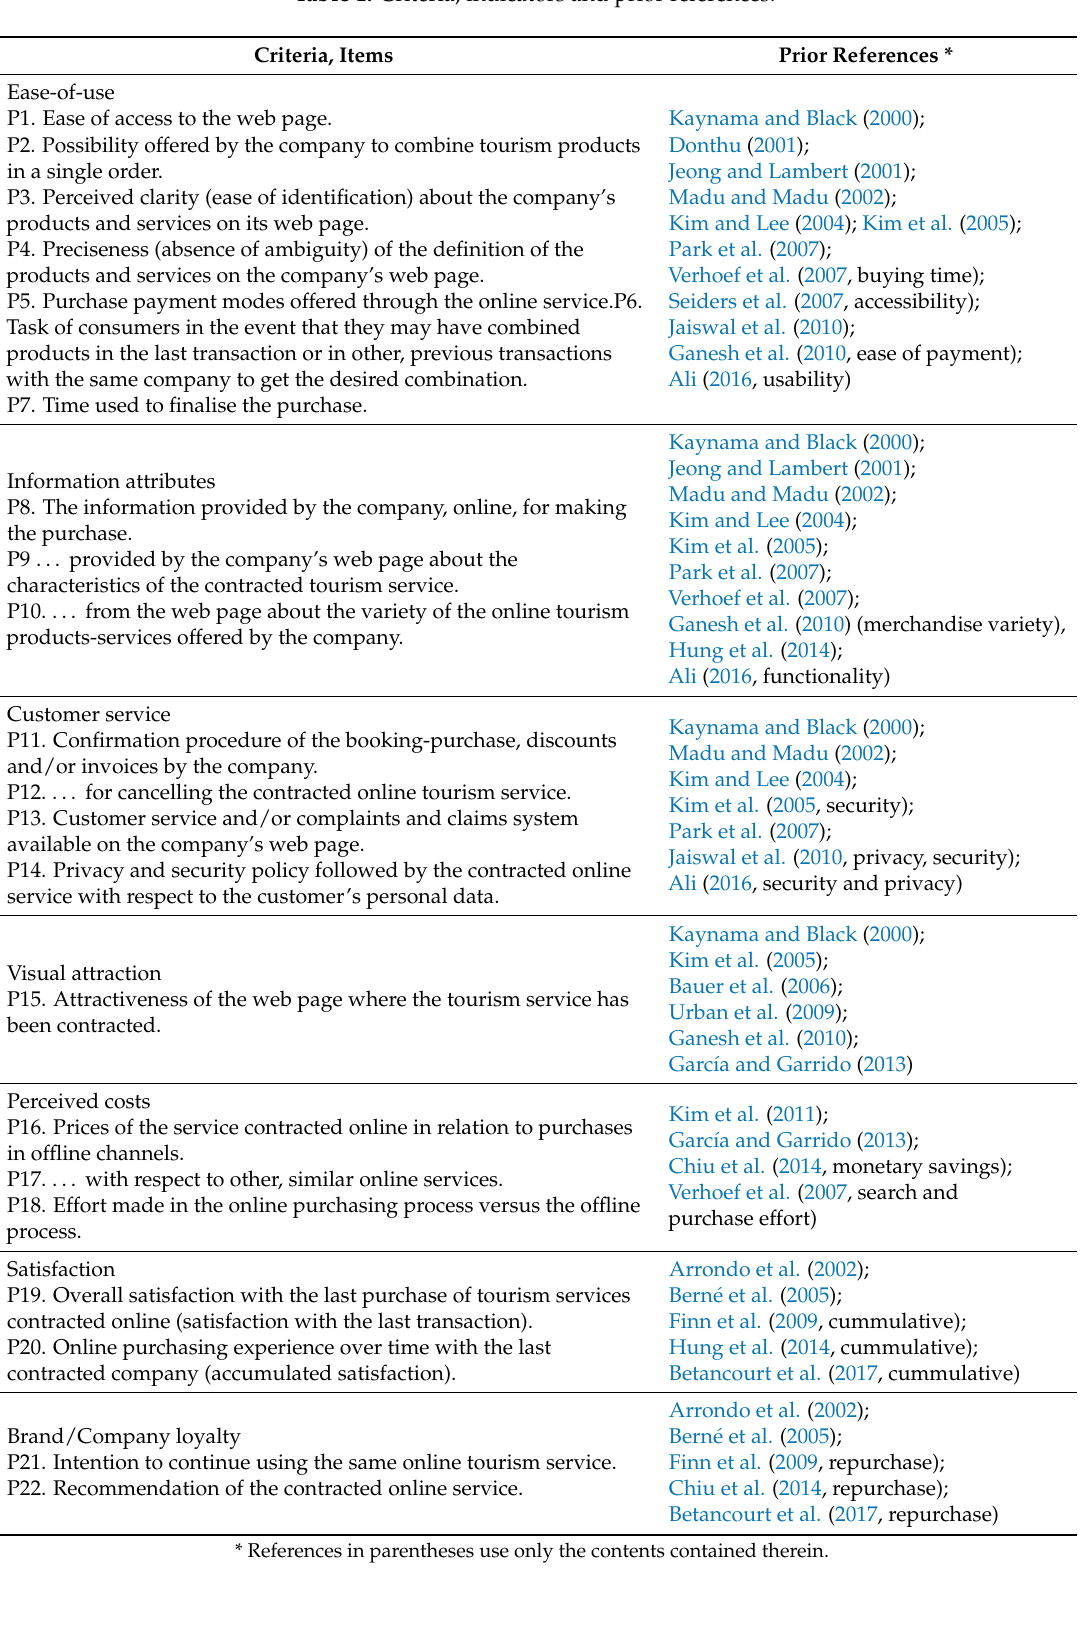
Table 1. Criteria, indicators and prior